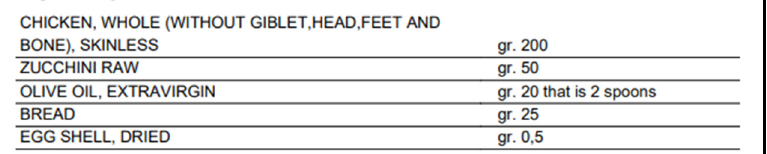
Figure 2. List of ingredients of the PRD. The image represents part of the PDF report provided by Myvetdiet © software after appropriate elaboration (English version, automatic translation from Italian language). RMD: raw meat diet; Gr: grams.